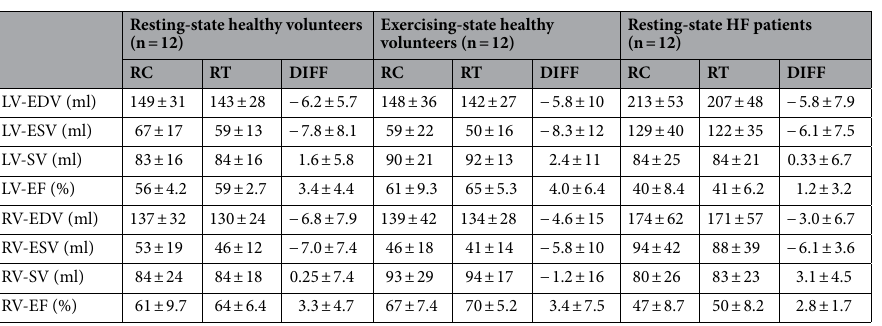
Table 2. Summary (mean ± standard deviation) of the volumetric measurements with retrospective cine (RC) and real-time (RT) images and the measurement differences (DIFF) between two methods.